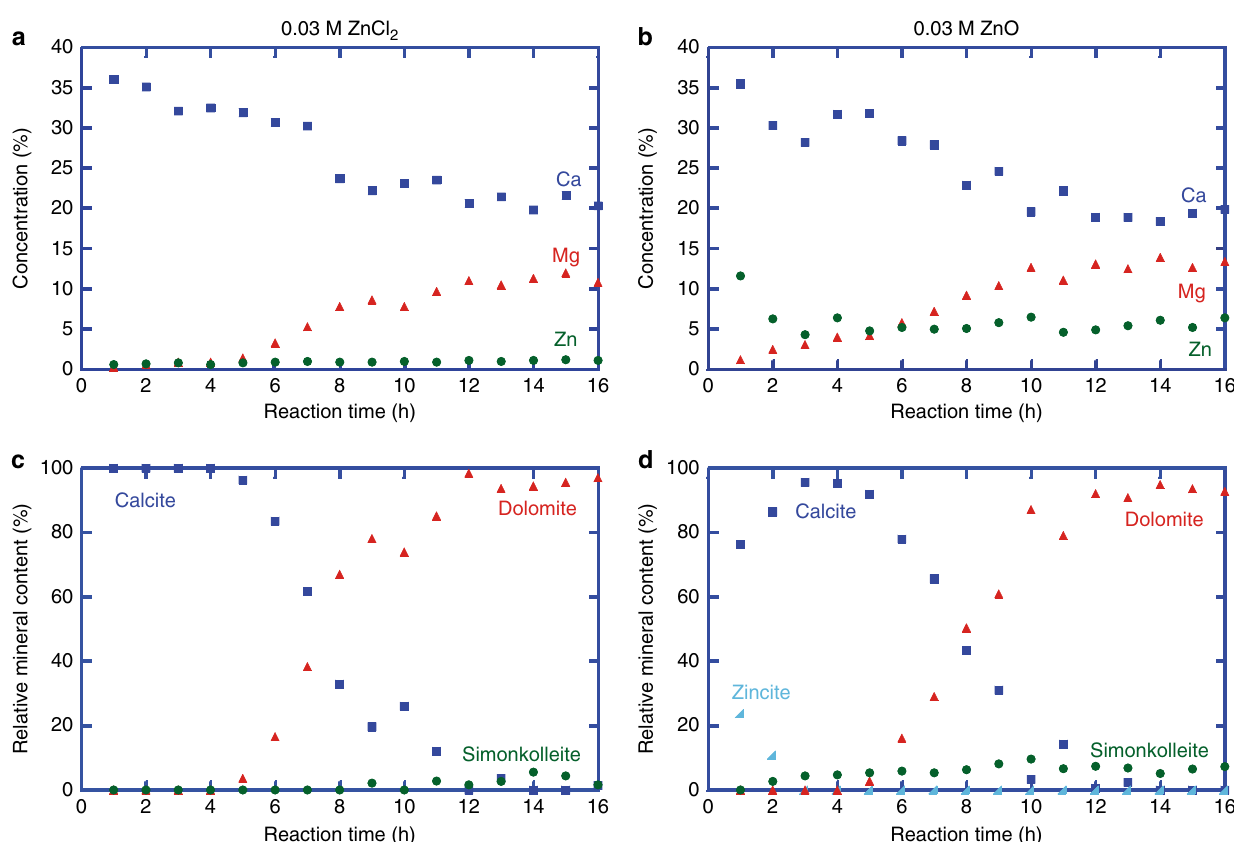
Fig. 3 Plots of geochemical and mineralogical data of reaction products against reaction time. The geochemical major element concentrations for the reaction products in the 0.03 M ZnCl 2 experiments ( a ) and in the 0.03 M ZnO experiments ( b ), as well as the relative mineral abundance for the reaction products in the 0.03 M ZnCl 2 experiments ( c ) and in the 0.03 M ZnO experiments ( d ) demonstrate very similar dolomitization reaction rates which are both accelerated compared to Zn-free solutions. The ZnO (zincite) experiments show dissolution of zincite within the fi rst three hours of the experiment and signi fi cantly larger amount of simonkolleite formed in the reaction ( d ) compared to the ZnCl 2 experiments ( c )